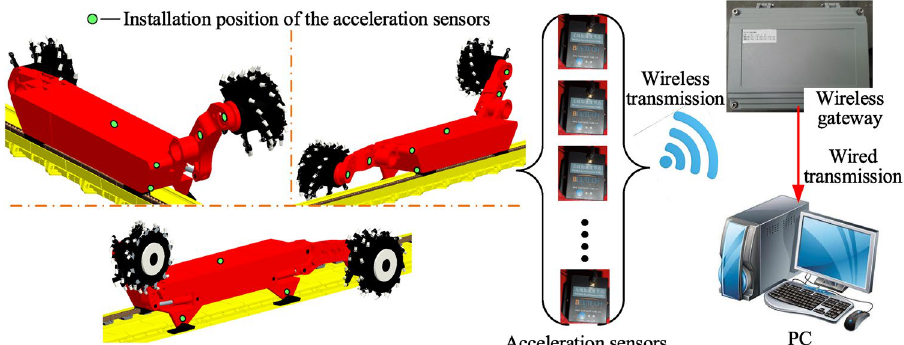
Figure 12. Vibration acceleration data acquisition system for key coal shearer components.